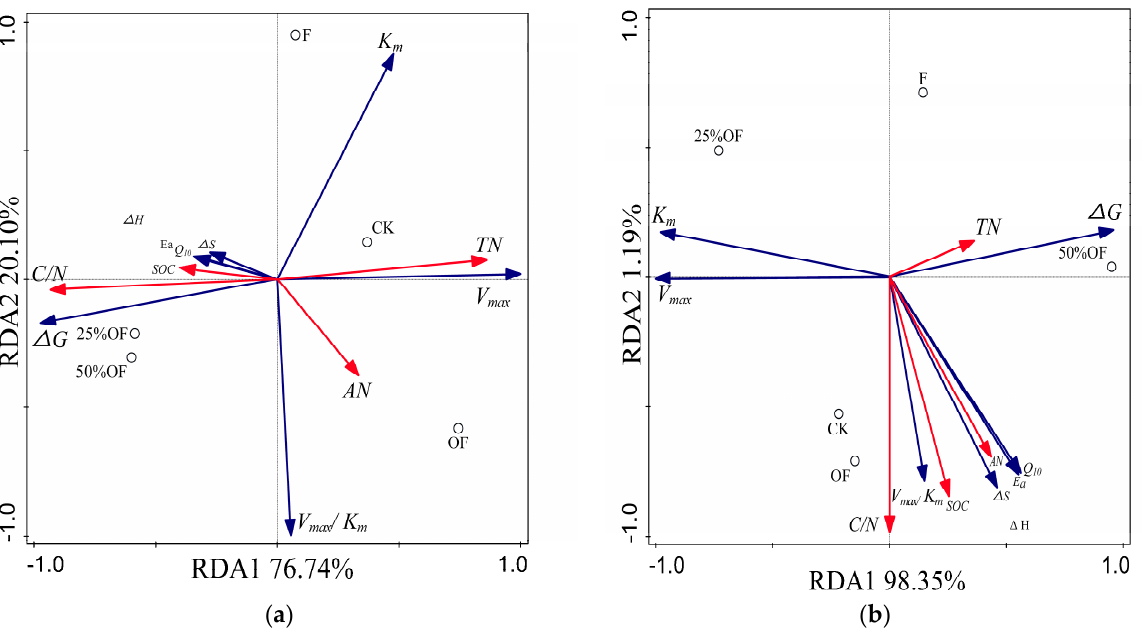
Figure 3. Redundancy Analysis (RDA) of relationships between soil properties and kinetic and thermodynamic parameters of soil β − glucosidase at the jointing stage ( a ) and booting stage ( b ) of spring wheat. Note: TN total nitrogen; AN alkali − hydrolyzable nitrogen; SOC organic carbon; C/N ratio of carbon to nitrogen.